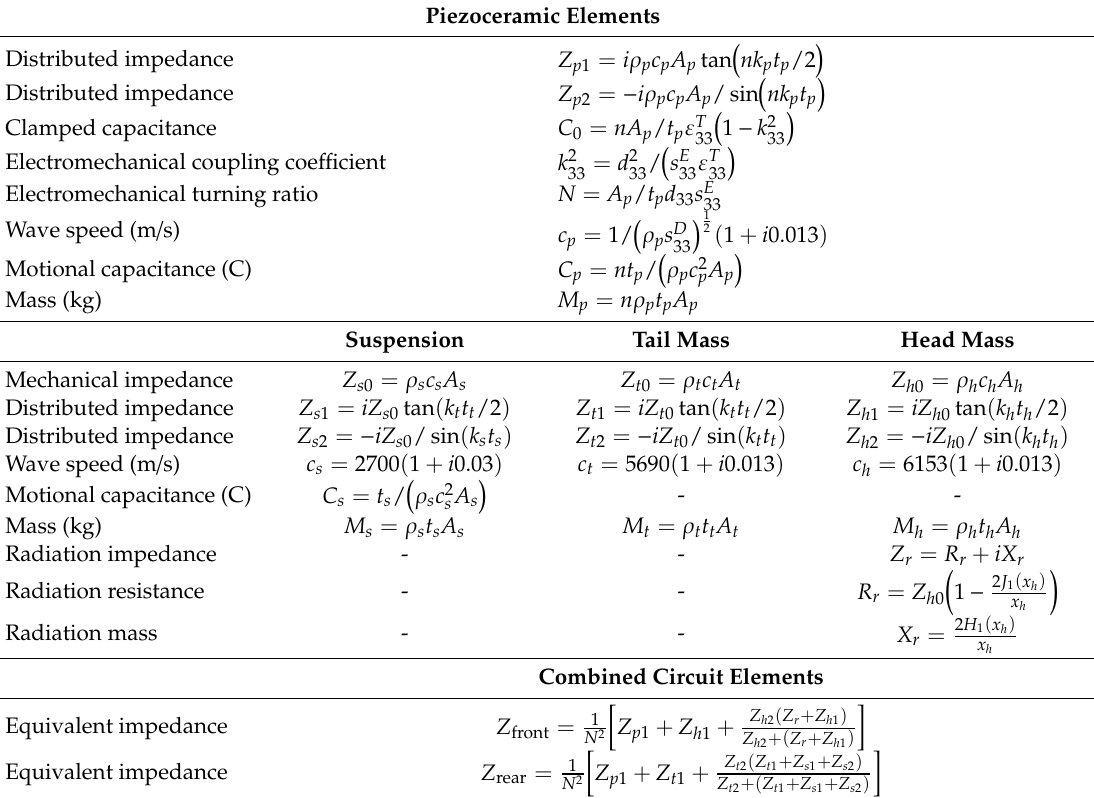
Table 2. Equivalent circuit parameters. A , n , and d 33 represent the area, the number of piezoceramic disks, and the piezoelectric strain constant, respectively. J 1 and H 1 are the first-order Bessel function and Struve function, respectively. The function variable x h denotes ( 2 π f / c h ) r h , where r h is the radius of the head